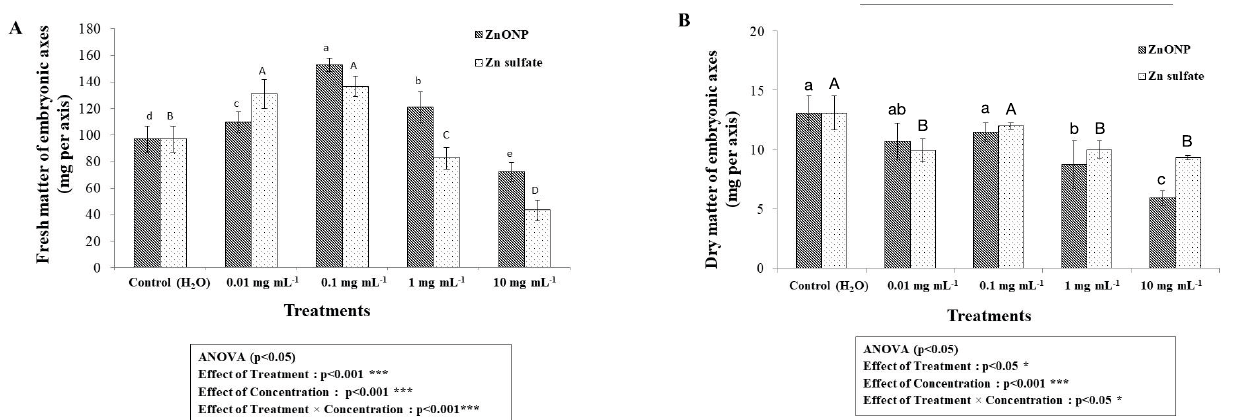
Fig. 3: Fresh matter (A) and dry matter (B) of the embryonic axes of Lathyrus sativa L. seeds germinated for 4 days in the presence of distilled water (Control) or solutions of ZnO NPs and ZnSO 4 at concentrations 0.01 mg ml -1 , 0.1 mg ml -1 , 1 mg ml -1 and 10 mg ml -1 . Values are means (±SD) of 5 inde- pendent measurements. Letters a-c and A-C denote statistic classes, respectively, for ZnONP and Zn sulfate, using Duncan test (α=0.05). Differences are significative, at *: 0.01≤P<0.05, **: 0.001≤P<0.01, ***: P<0.001, and non significant NS at P≥0.05.